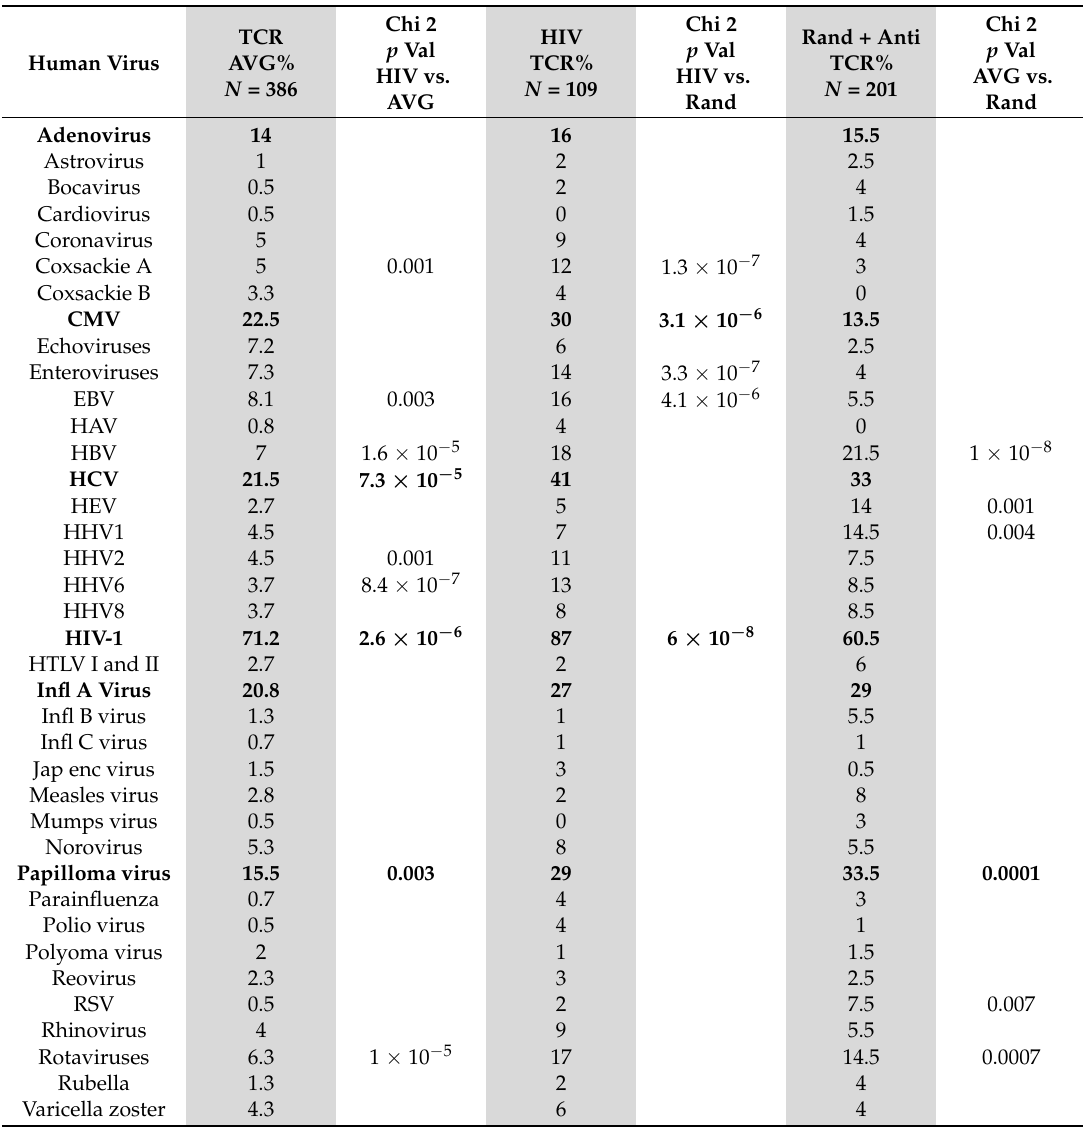
Table 1. HIV mimics TCR far more frequently than any other